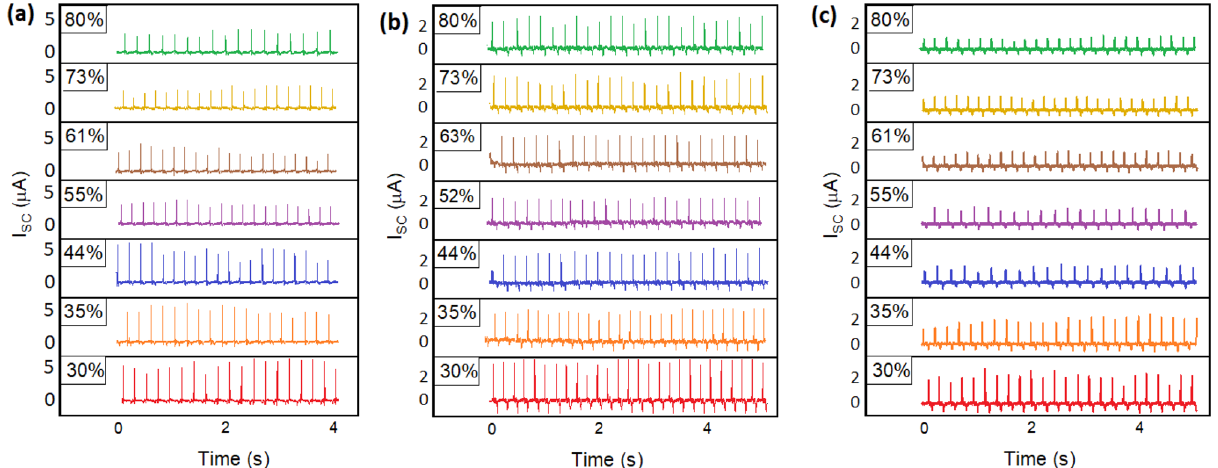
Figure 6. Variation of short-circuit current for TENGs based on dense PDMS ( a ), porous PDMS ( b ), and porous CNT-PDMS ( c ) electrodes.